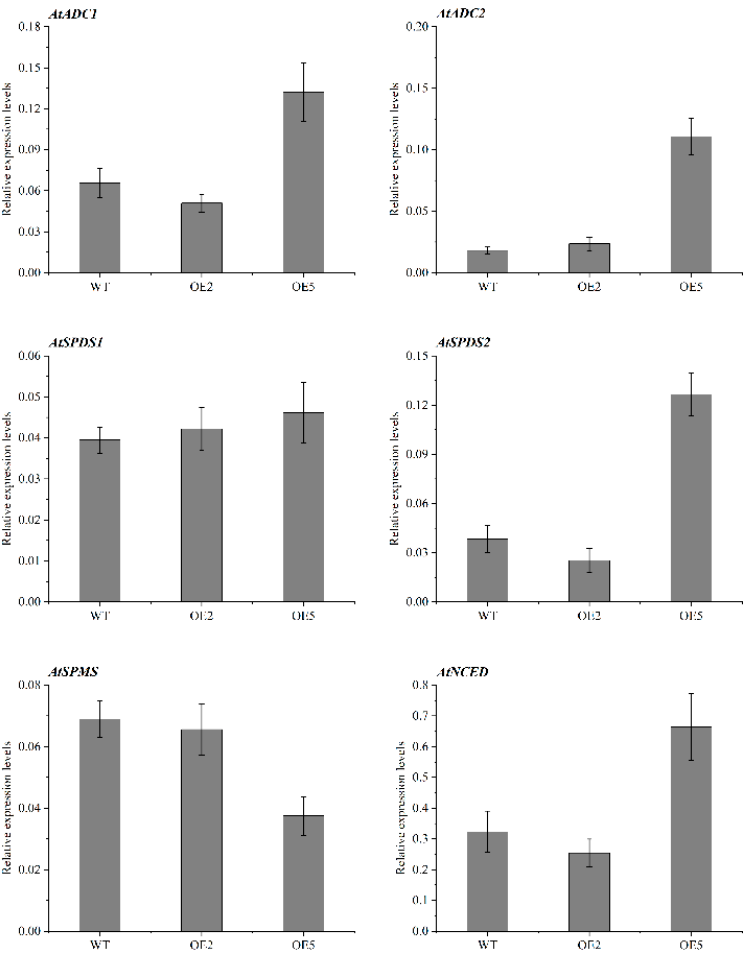
Figure 11. Transcription levels of PA and ABA synthesis genes in overexpressed plants.